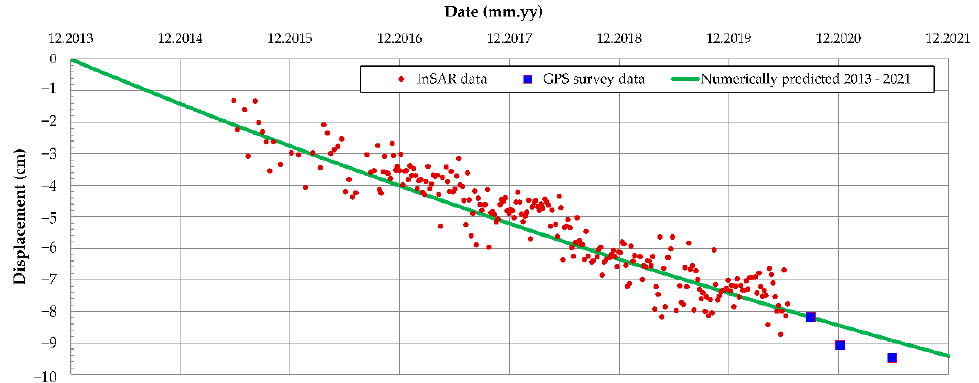
Figure 16. Numerically obtained displacements of the Oostmolendijk for the identified creep parameters.